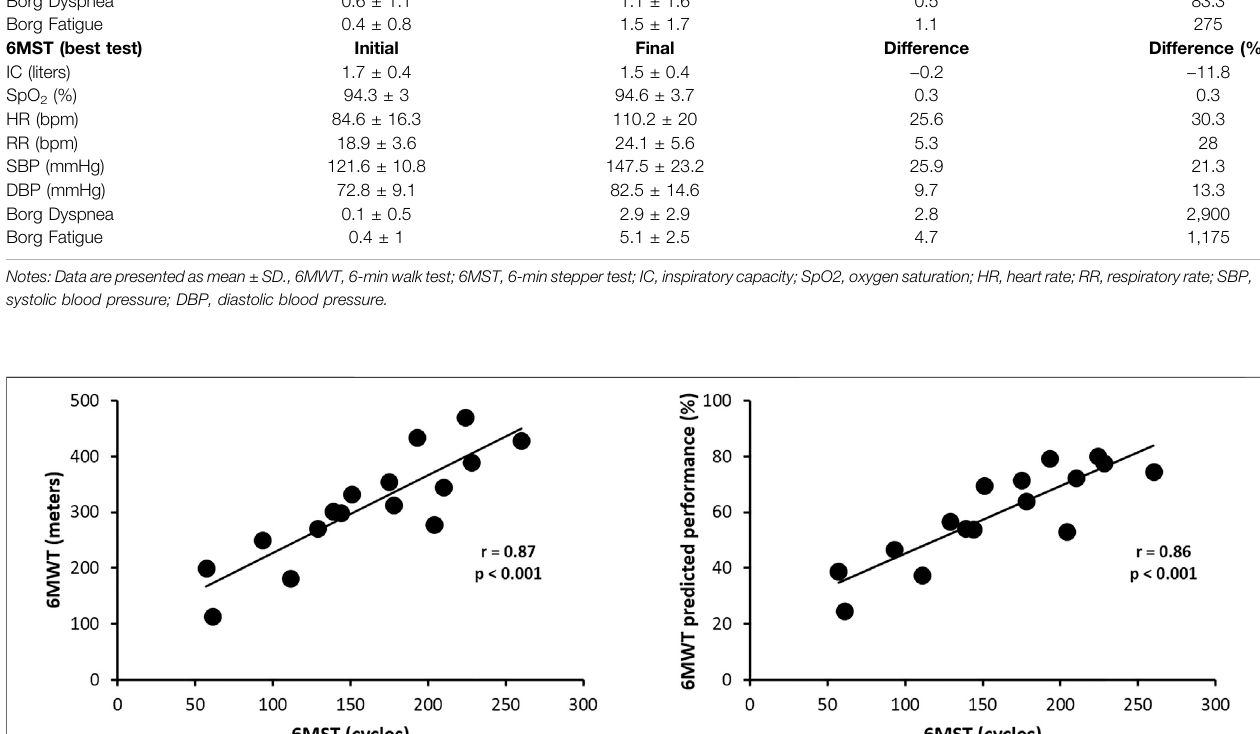
Frontiers in Physiology |